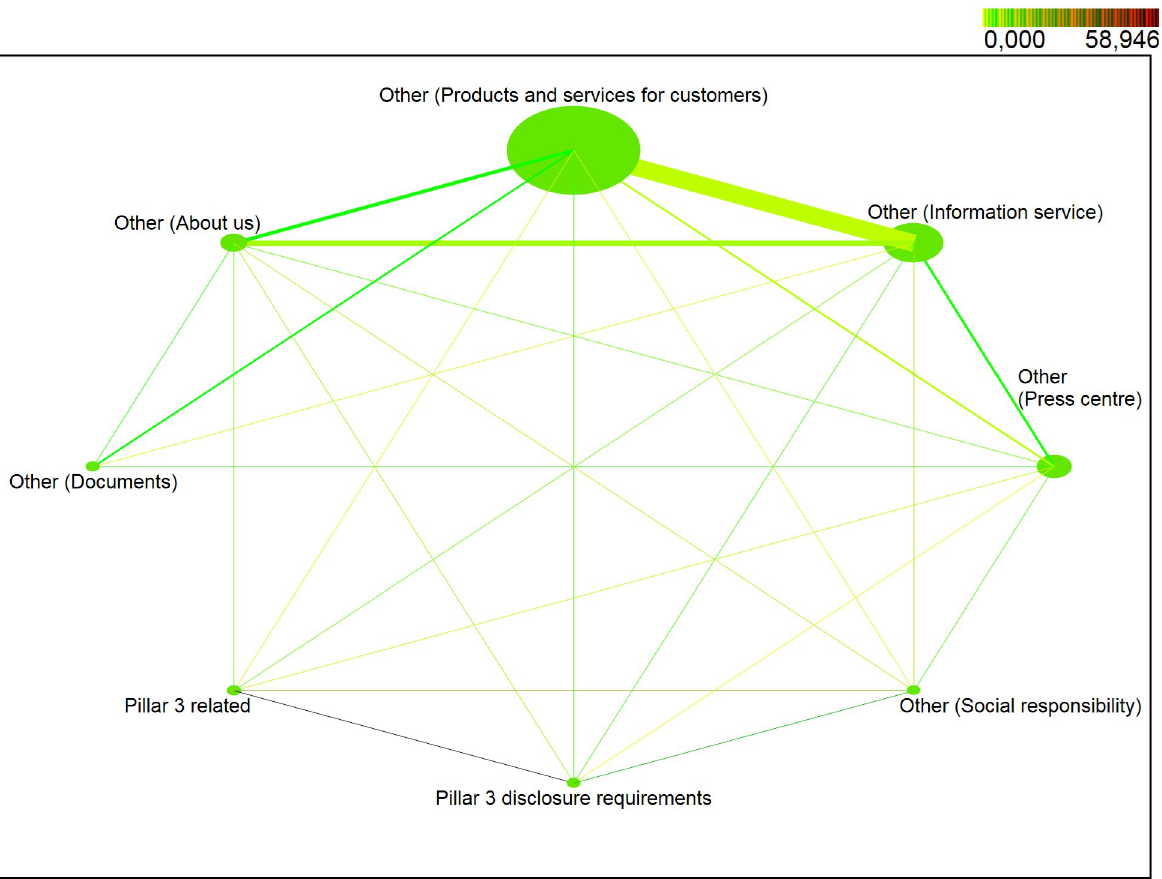
Fig 8. Visualization of frequented web parts of the fourth quarter of